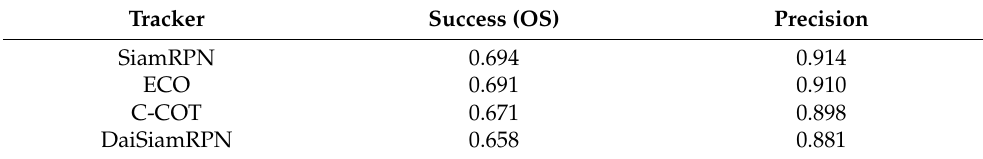
Table 3. Evaluation of OTB100 by the system.